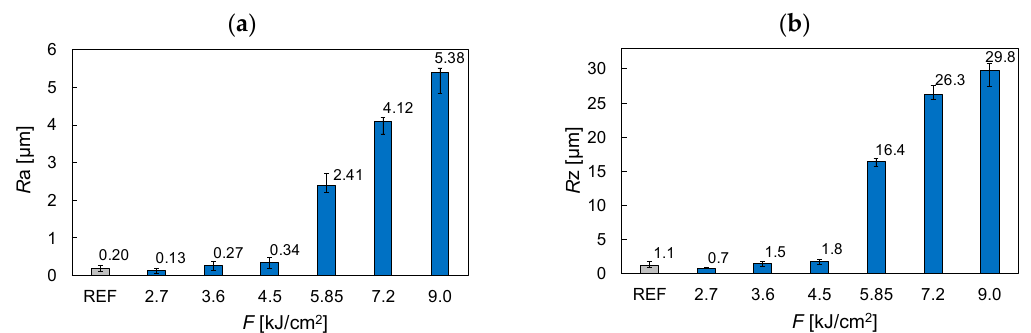
Figure 2. The average values of roughness parameters for the reference and laser-irradiated samples, including ( a ) the mean roughness R a and ( b ) the largest profile height R z.